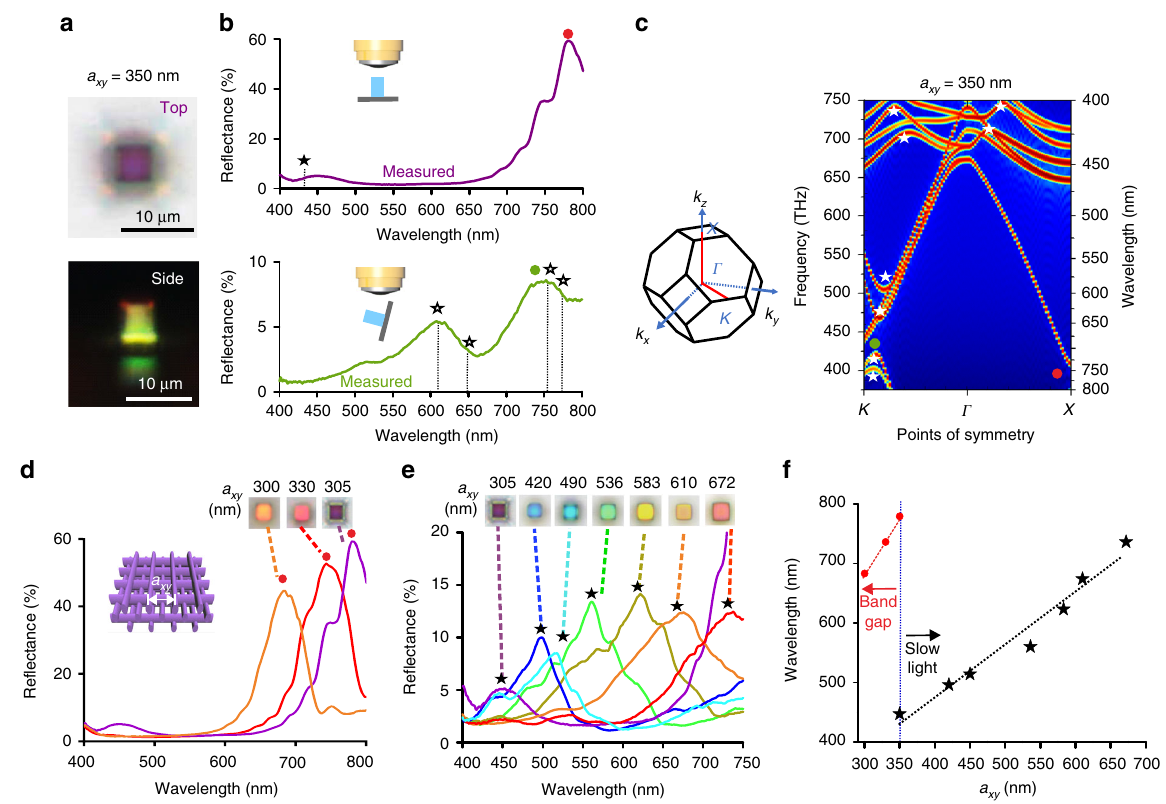
Fig. 2 Re fl ectance and bandstructure of a woodpile photonic crystal with a xy = 350 nm, a z = 614 nm. a Top view (top) and side view (bottom) re fl ection- mode optical micrographs of the woodpile photonic crystal. b Re fl ectance of the woodpile photonic crystal measured with top-down illumination (top) and side illumination (bottom). c First Brillouin zone and photonic bandstructure of the woodpile photonic crystal in the Γ – K and Γ – X directions. Stars indicate slow light modes and dots indicate stopbands. d , e Re fl ectance spectra and re fl ection-mode micrographs of woodpiles under top-down illumination conditions for a xy = 300 – 350 nm ( d ) and a xy = 350 – 672 nm ( e ), respectively. f Plot of re fl ectance-peak positions as a function of the lattice